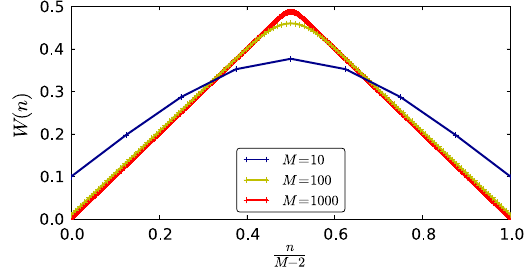
FIG. 9. The weight function according to Eq. (29) for various truncation lengths M in a SSE